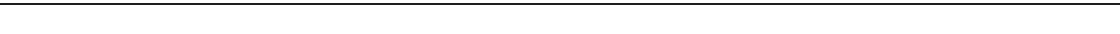
Fig. 2 Rbfox1 is a pro-survival factor that regulates follicular epithelium differentiation. a In starved females, Rbfox1-overexpressing clones ( Rbfox1 OE , GPF- positive, hsFlp; UAS-Rbfox1-RE/ + ; act > CD2 > Gal4 UAS-GFP ) have higher cell density and decreased cell death. Note condensed DNA (separate channel, arrows) in non-clonal control cells, which die in response to starvation. b Abnormal autophagy measured by the signi fi cantly increased Atg8 intensity in Rbfox1 OE ( n = 27) versus neighbouring control cells within the same egg chamber ( n = 27); c Decreased apoptosis in Rbfox1 OE cells detected by the reduced Caspase3 intensity ( Rbfox1 OE, n = 28, Control, n = 35). d Even without starvation, Rbfox1 overexpression reduces cell growth, illustrated by the signi fi cantly decreased Myc expression in Rbfox1 OE clones in comparison to the equal size of the non-clonal neighboring area within the same egg chamber ( n = 17). e Rbfox1 OE cells express higher levels of the cell adhesion proteins Cadherin (DE-Cad, n = 10 clones) and β -Catenin (Arm, n = 5 clones), and form a multilayered epithelium (arrow, f ). g , h Temporal regulation of the Notch-dependent transcription factor Cut is abnormal, showing that activation of Notch signaling required for proper follicle cell differentiation is slowed-down upon Rbfox1 overexpression ( g ). i When Rbfox1 is downregulated, Cut expression is also abnormal. h Bar graph and scheme show that timely repression or activation of Cut is delayed in the endocycling (st.6-10a) or amplifying (st.10b-14) mutant follicular epithelial cells, respectively. Cut expression during endocycling stages was detected in 20% and 80% of clones that have higher or lower Rbfox1 levels, respectively, in comparison to 0% in control non-clonal cells. At the same time, signi fi cantly higher percentages, 80% and 70% of clonal cells with overexpressed or downregulated Rbfox1, failed to turn on Cut expression during ampli fi cation stages ( n = 19 and 43 clones for Rbfox1 OE and Rbfox1 KD , respectively). j Scheme represents miR-980 /Rbfox1 function in response to nutritional stress. Upon stress, miR-980 levels are reduced, causing Rbfox1 upregulation and promoting cell survival. Images in a – g and i are maximum intensity projections of multiple Z- sections. Scale bars 5 µ m. Developmental stages (st.) of egg chambers are marked. Relative antibody staining intensity (AVE ± AD) is presented as relative to control ( b – e ). Student ’ s t -test was applied for statistics in b – e and Chi square in h , * p ≤ 0.05; ** p ≤ 0.01; *** p ≤